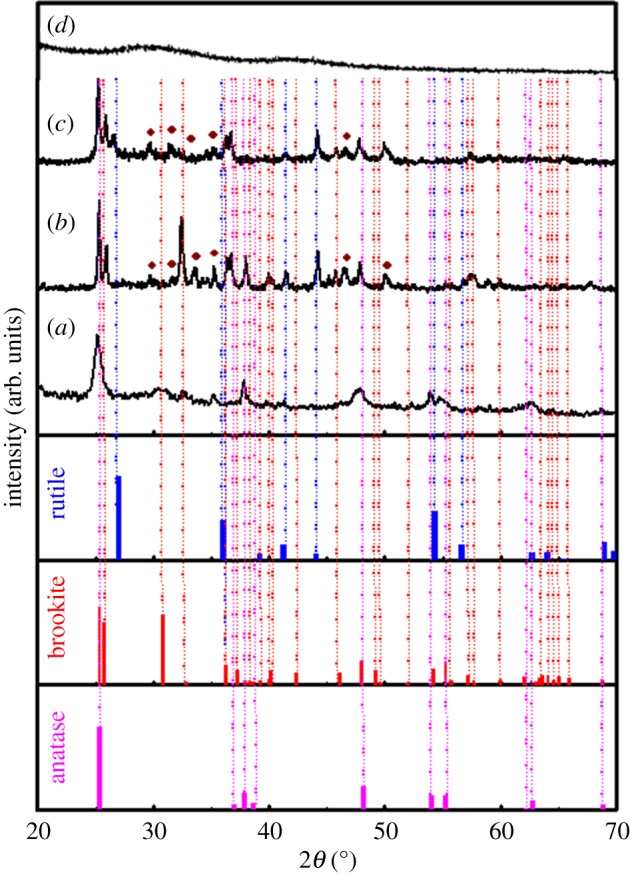
XRD patterns of (a) TiO2, (b) TiO2: Sr, (c) TiO2: Sr/r-GO, (d) r-GO.